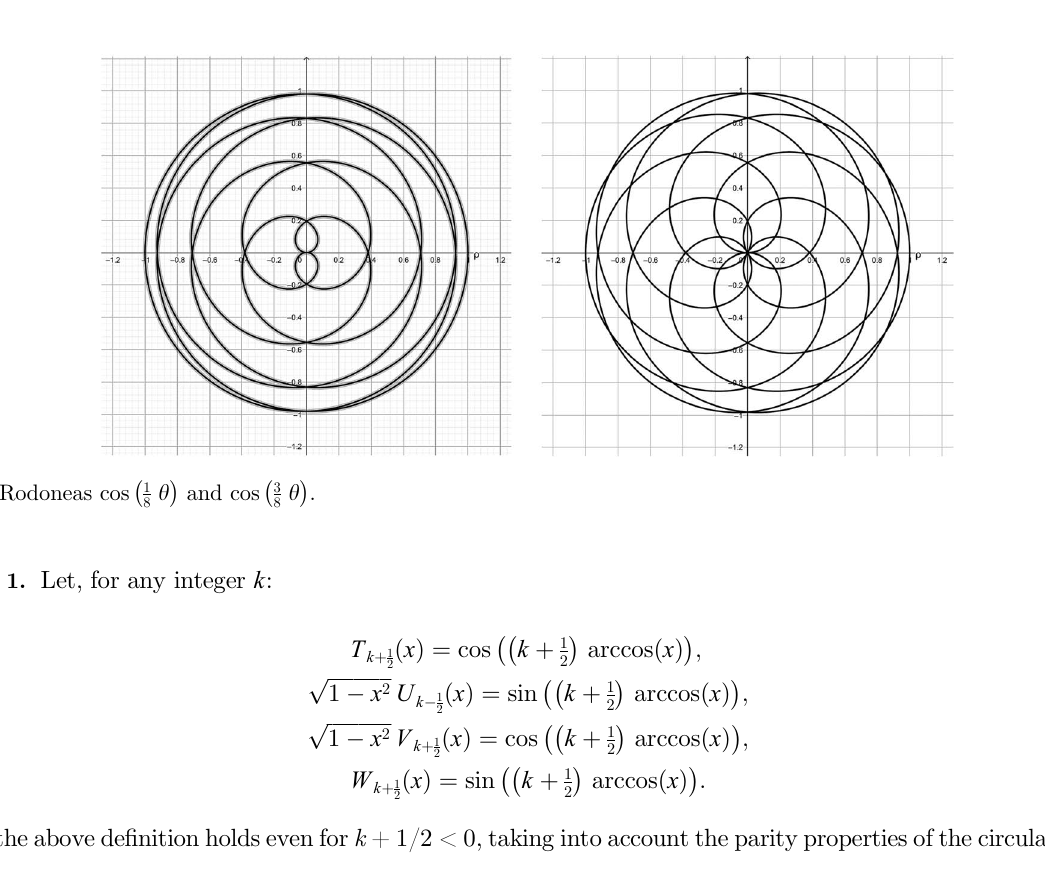
Figure 6. Rodoneas cos 1